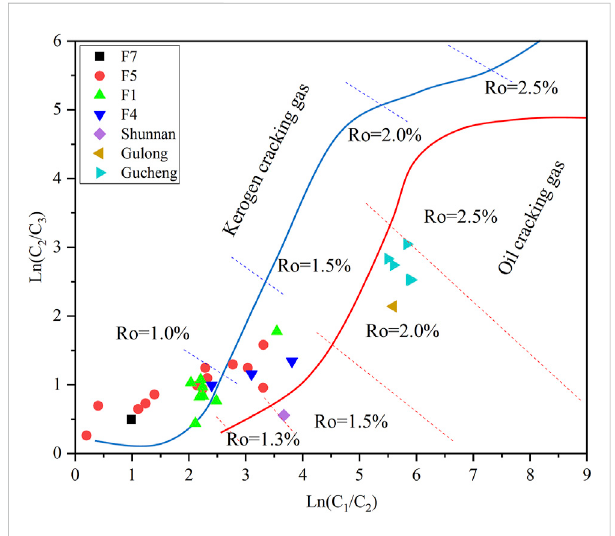
FIGURE 7 The diagram of ln (C 1 /C 2 ) versus ln (C 2 /C 3 ) for source identi fi cation of natural gases: kerogen cracking and oil cracking (Modi fi ed from Berner et al., 1996; Huang B. J. et al., 2016; Stahl et al., 1975).